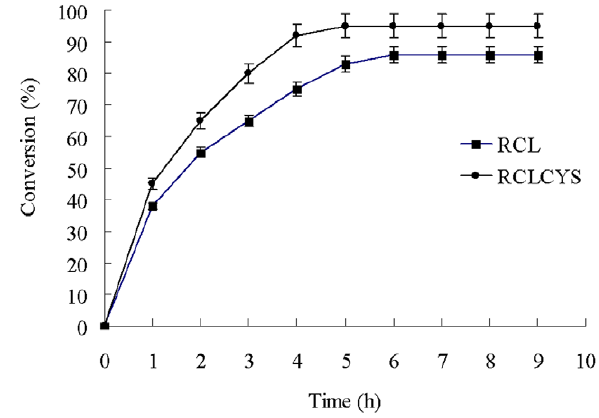
Figure 5. Proposed substrate binding region of RCLCYS in an open form. Red, the introduced disulfide bond; Blue, the catalytic triad of S145-H257-D204; Yellow, the substrate binding region.